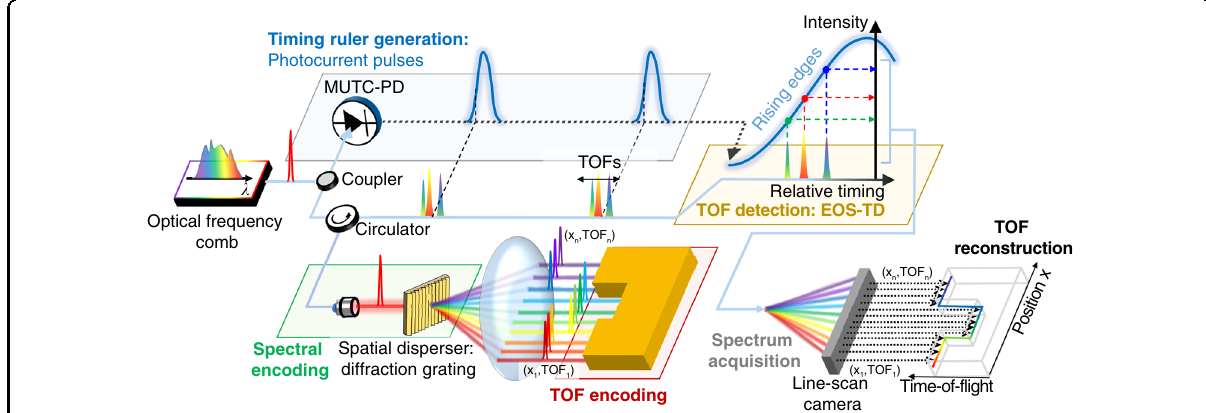
Fig. 1 Operation principle of the electro-optic sampling-based line-scan TOF camera. A mode-locked Er- fi bre oscillator is used as the optical frequency comb source. For the timing ruler generation, an MUTC-photodiode is used to generate ultralow-jitter photocurrent pulses. For the target imaging, the optical pulses are expanded and spectrally dispersed for space-to-wavelength encoding. After re fl ected from the target, the TOF- encoded sub-pulses are collected and applied to an EOS-TD for TOF-to-intensity conversion. The EOS-TD output spectrum is analysed with a line- scan camera to simultaneously reconstruct TOF pro fi les of >1000 spatial